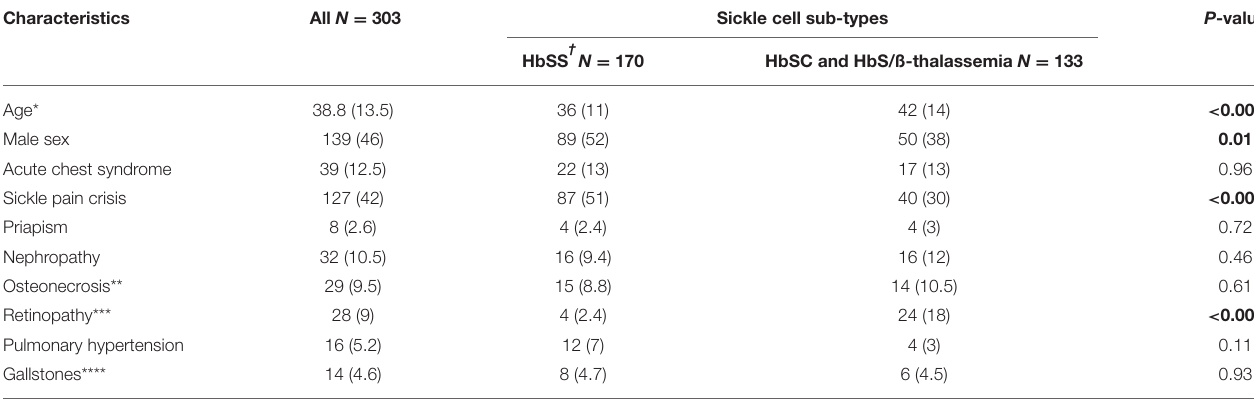
TABLE 1 | Demographics and common phenotype of sickle cell sub-types.